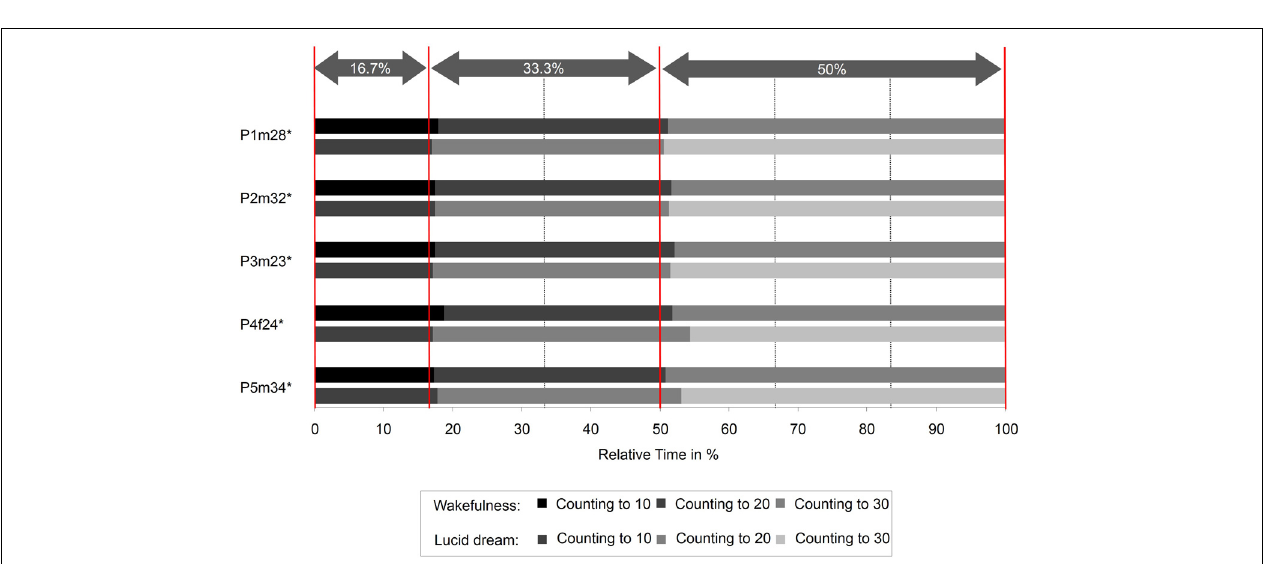
FIGURE 3 | Absolute durations for the counting task during wakefulness and lucid dreaming (Labels: e.g., P1m28 = Participant 1, male, 28 years. ∗ Participants of the counting task also completed the walking task).